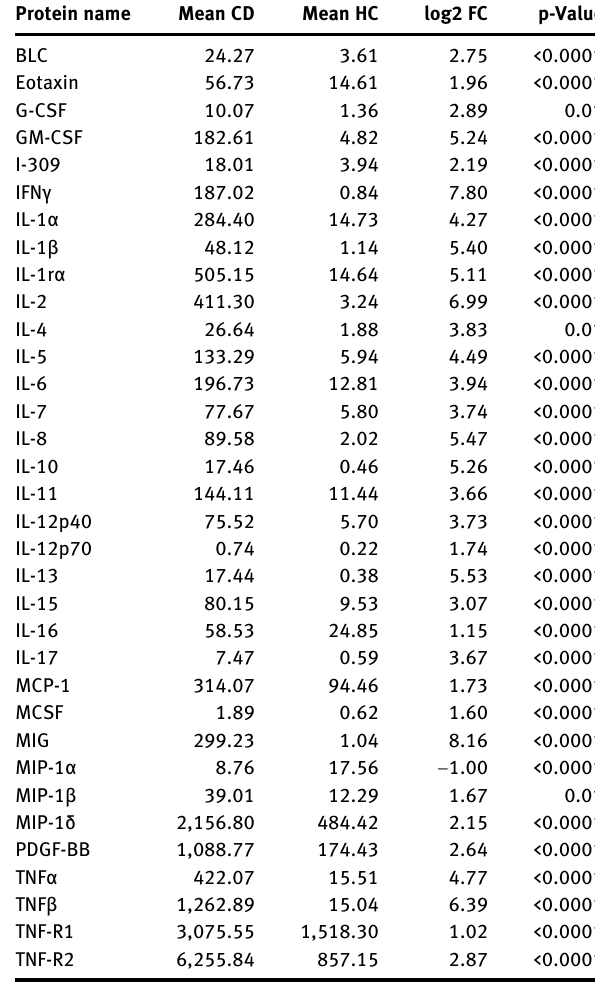
Table  : Differential expressed serum proteins between  anal fi stulas with CD and six healthy samples detected by antibody arrays.